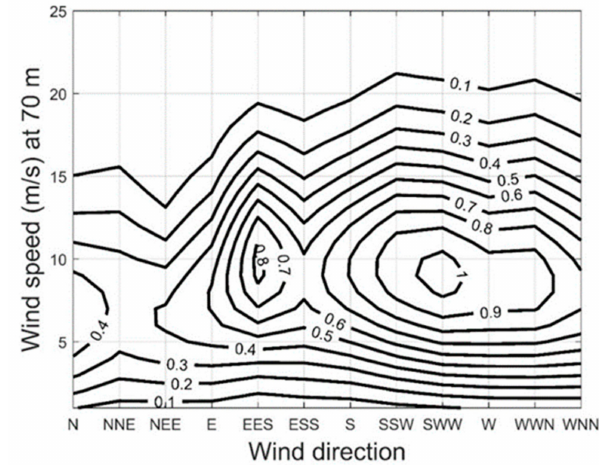
Figure 2. Contours of frequency of occurrence, f , of wind speed and direction at hub height for Horns Rev 1, adapted from